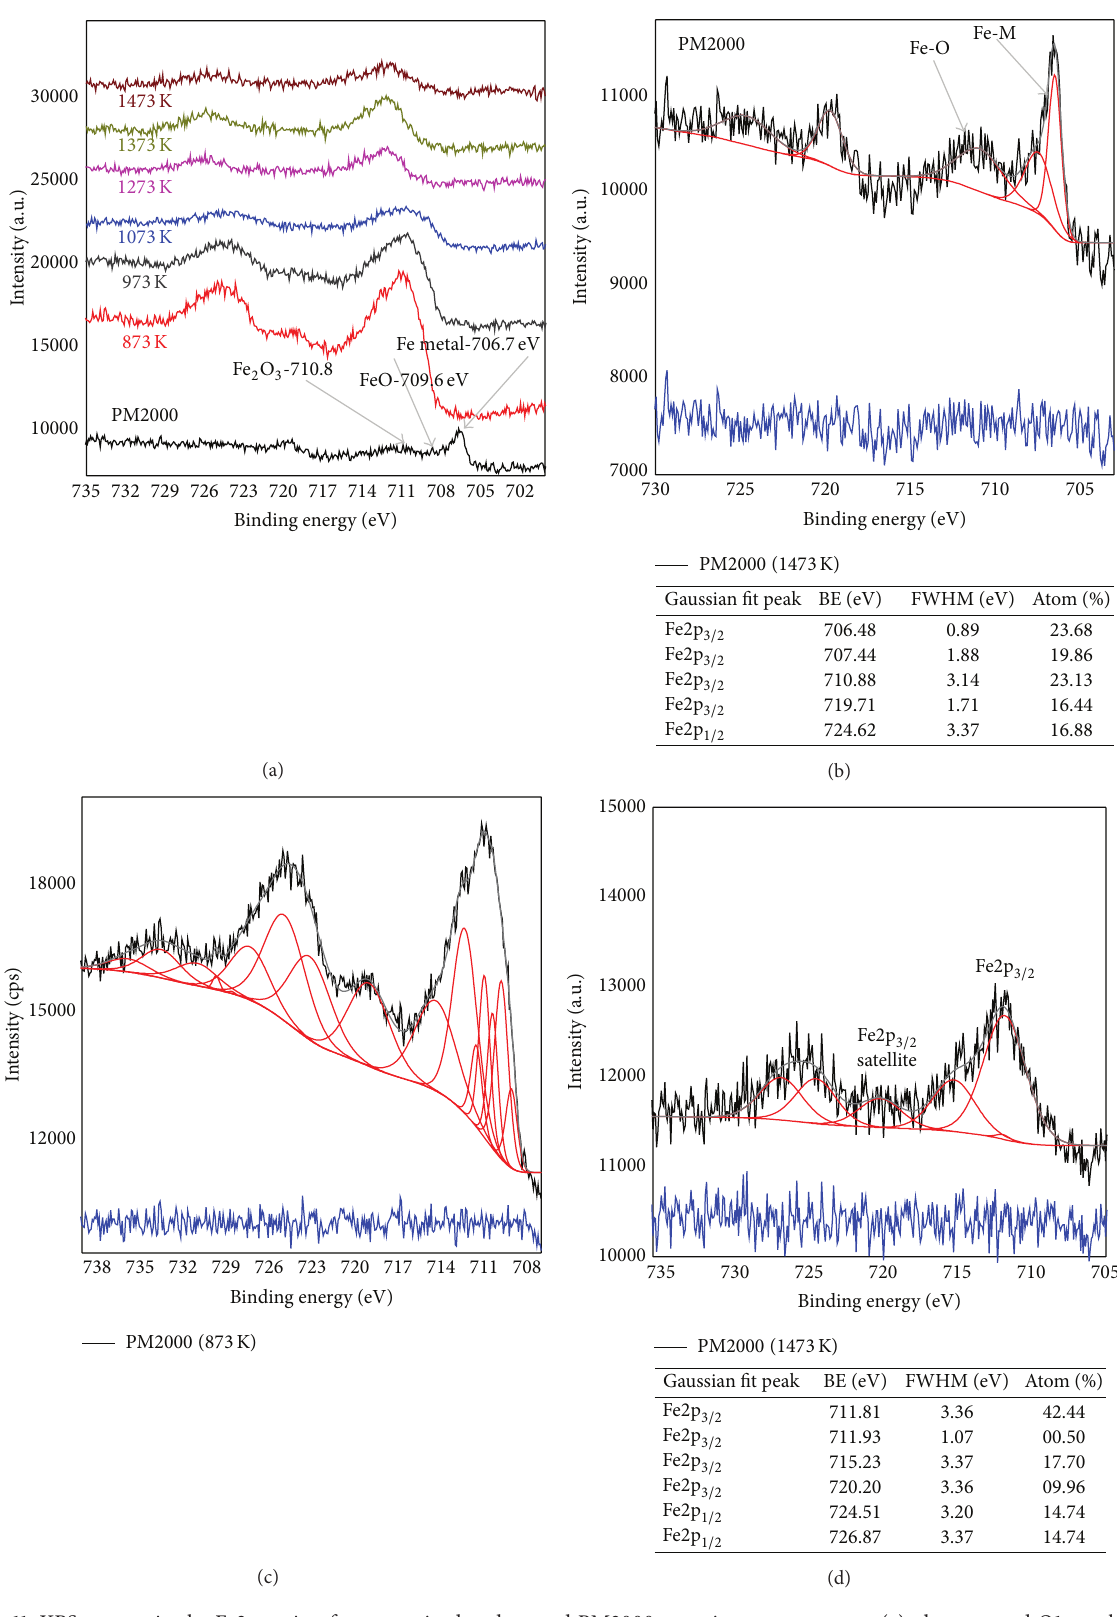
Figure 11: XPS spectra in the Fe2p region for as-received and treated PM2000 at various temperatures (a), decomposed O1s peaks of as- received PM2000 (b), decomposed O1s peaks of oxidized PM2000 at 873 K (c), and decomposed O1s peaks of oxidized PM2000 at 1473 K